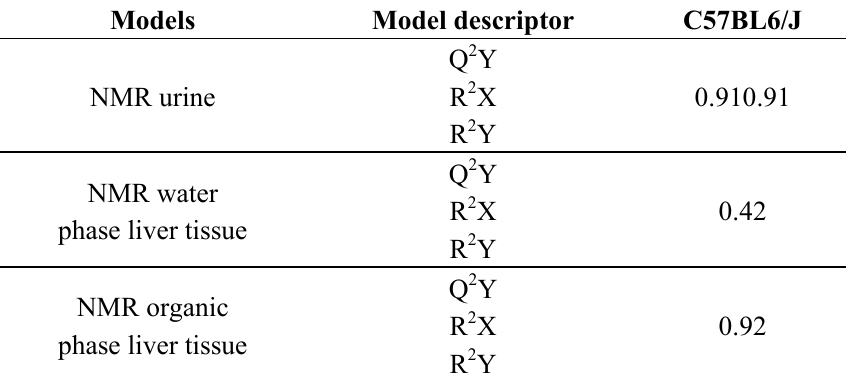
Table A4. O-PLS-DA model summary for discriminating for 1 H-NMR profiling of urine, liver tissues for the C57BL6/J